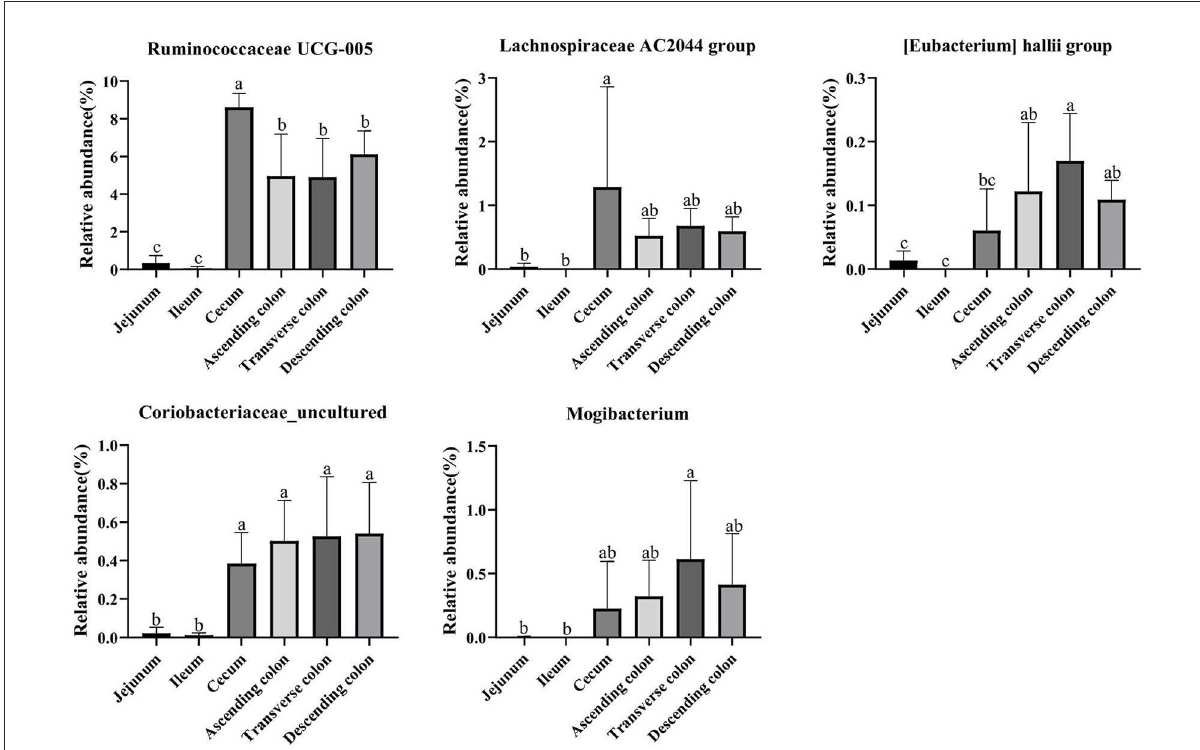
FIGURE11 The relative abundance of Ruminococcaceae UCG-005 , [Eubacterium] hallii group, Lachnospiraceae AC2044 group, Coriobacteriaceae_uncultured and Mogibacterium in different intestinal locations of pigs. Data are shown as mean ± SD ( n = 6). The same letter within each column indicates no significant difference ( p >